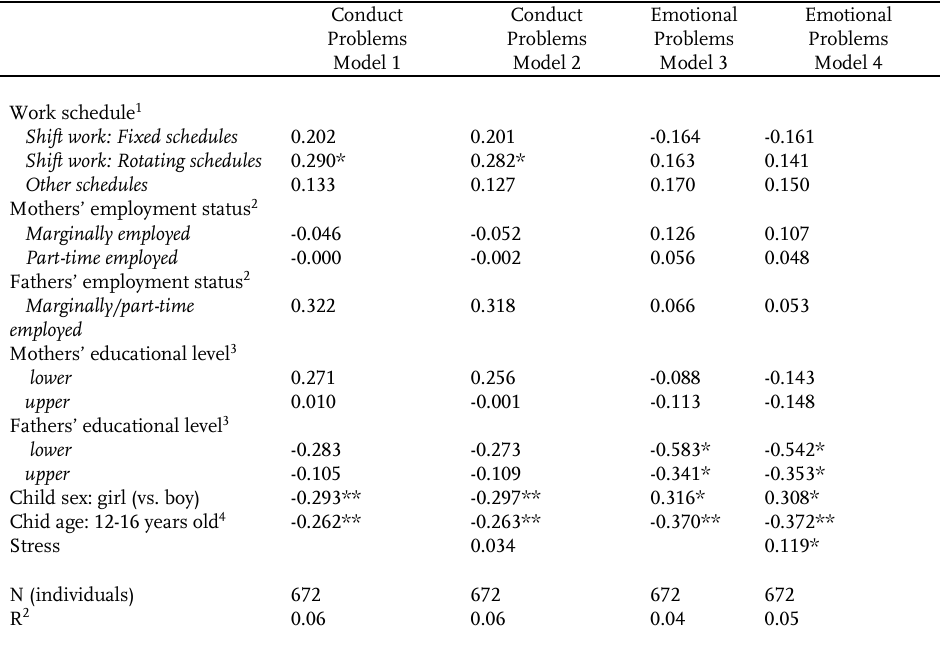
Table 4 : Effects of fathers’ shift-work on children’s conduct and emotional problems (reported by child), random-effects regression Conduct